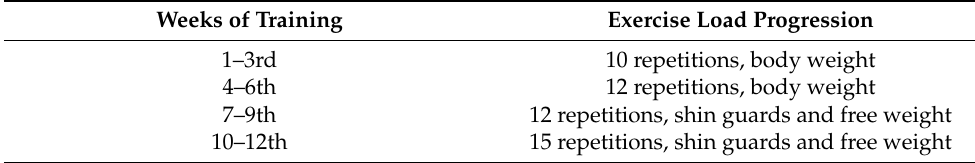
Table 1. Exercise load